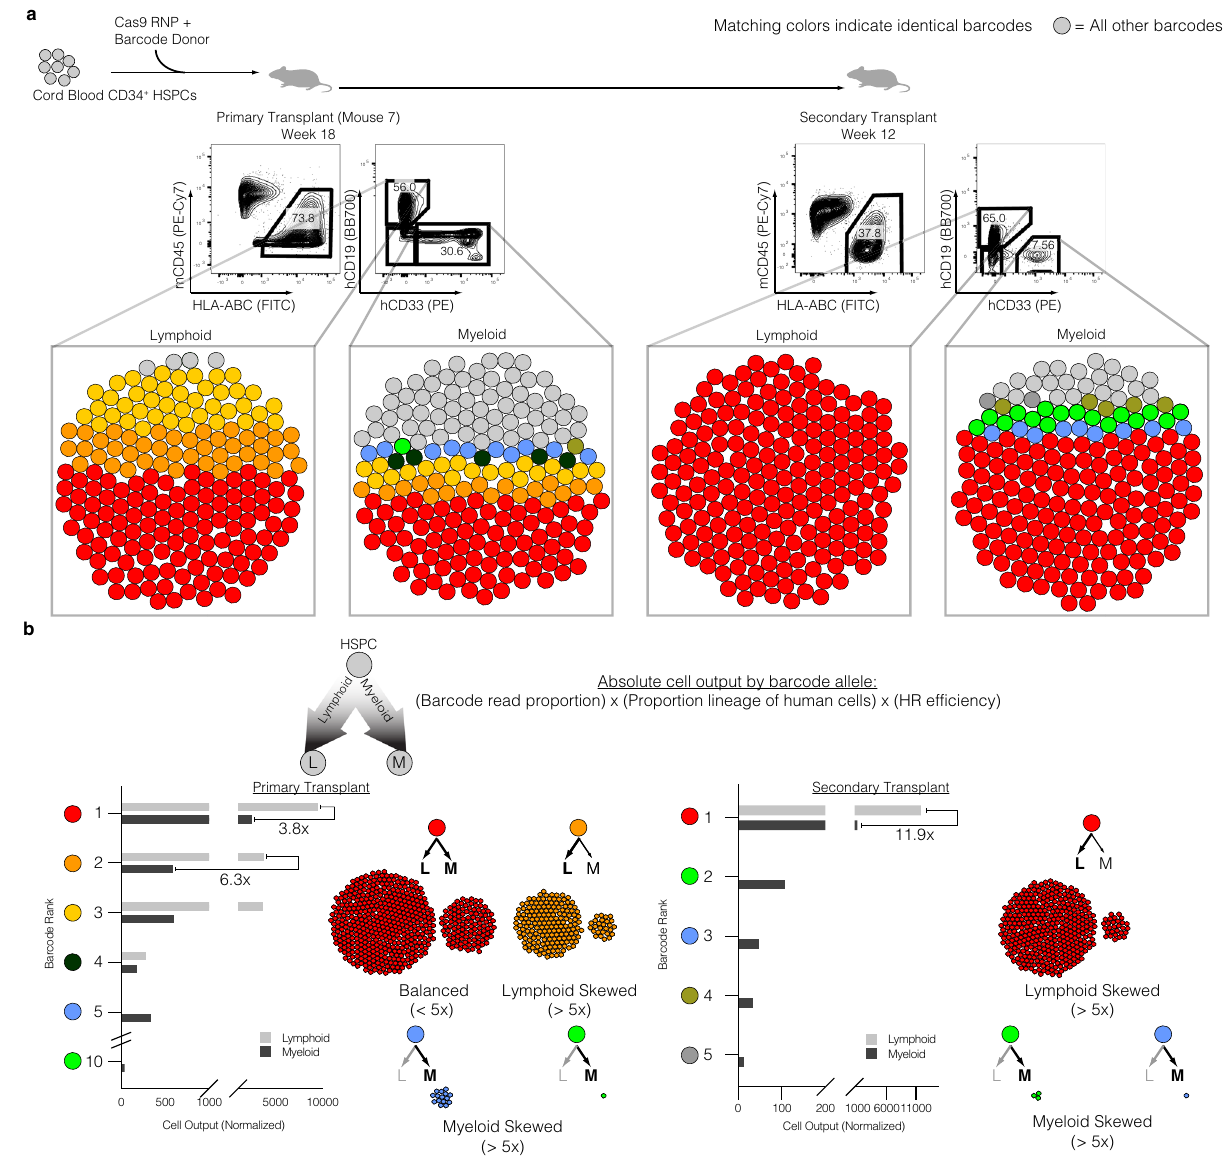
Fig. 5 Clonal tracking of AAVS1 barcoded targeted HSPCs in reconstituting primary and secondary NSG transplants. a Top: Experimental schematic. Middle: Flow cytometry plots representing bi-lineage engraftment in primary transplant (left, week 18 post-transplant) and secondary transplant (right, week 12 post-transplant). Bottom: Bubble plots representing barcode alleles as unique colors from each indicated sorted population. Shown are the three most abundant clones from all six populations. All other barcodes represented as gray bubbles. b Normalized output of barcode alleles with respect to lineage contribution. Total cell output (bar graphs) from indicated barcodes adjusted for both differential lineage output and genome editing ef fi ciency within each subset. Examples of various lineage skewing depicted, with cell counts re fl ecting relative contributions to the xenograft. One highly engrafted mouse (Mouse 7) depicted of n = 5 total. Skewed output de fi ned as 5-fold or greater bias in absolute cell counts towards lymphoid or myeloid